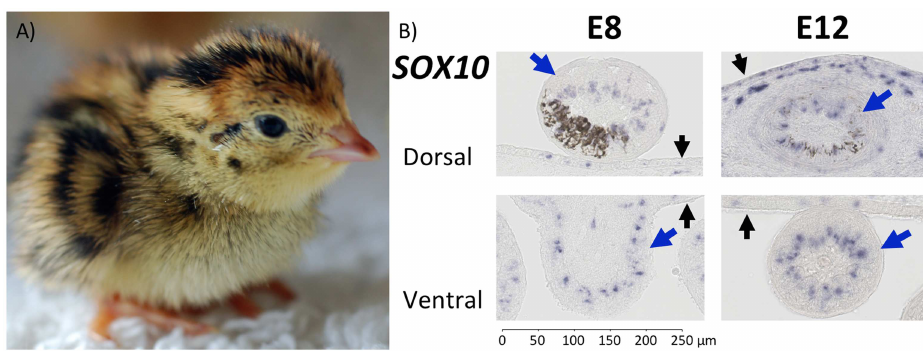
Fig 1. Japanese quail ( Coturnix japonica ) chick and melanocyte distribution at embryonic stages E8 and E12. A) The dorsal pigmentation of C . japonica comprisesalternatingstripes of dark and light feathers that are uniformly pigmented with one type of melanin, as well as feathers that are pigmented with both eumelanin and pheomelanin. Photo by CowgirlJules / CC BY 2.0. B) In situ hybridizationfor SOX10 to determine melanocytedistribution in Japanesequail feather folliclesduring embryogenesis at E8 and E12. Feather follicles are labelledwith a large blue arrow and the epidermis with a small black arrow. At E8 and E12 eumelanin is rarely present in ventral feather folliclesbut is frequently observedin feather follicles on the dorsal surface. Melanocytes are present within the epidermis and feather follicles. Stainingof SOX10 occurs in areas where individualbarbs are developing in feather follicleson both the ventral and the dorsal surface of E8 and E12 quail embryos. The distributionof melanocytes is not restricted to areas pigmented with melanin but also occurs where melaninis